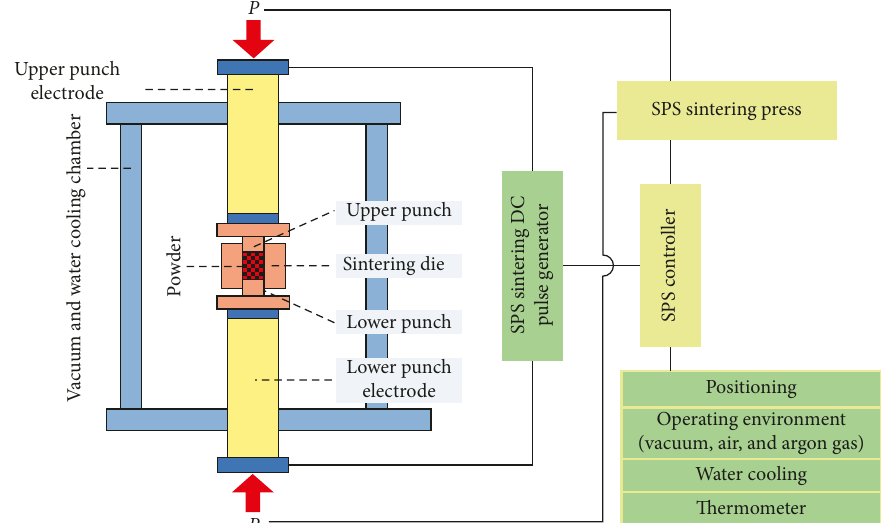
Figure 9: Typical spark plasma sintering (SPS) setup, as adopted from [87].